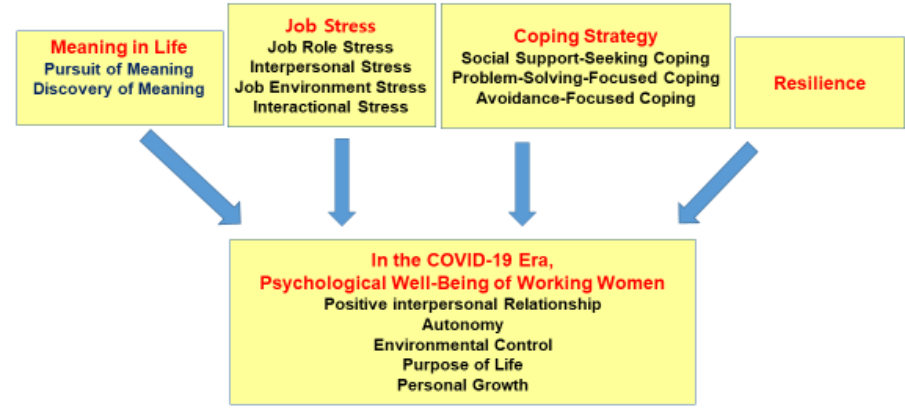
Figure 1. Research design of the study.